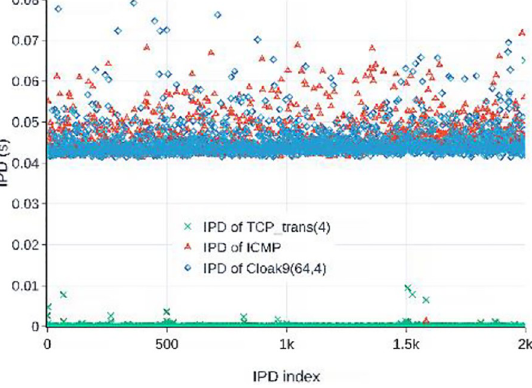
Fig 2. IPD samples produced by Cloak 9 (64,4), ping command, and TCP_trans(4) between 2 hosts. TCP_trans(4) is a channel with 4 mutually independent TCP connections between 2 hosts.